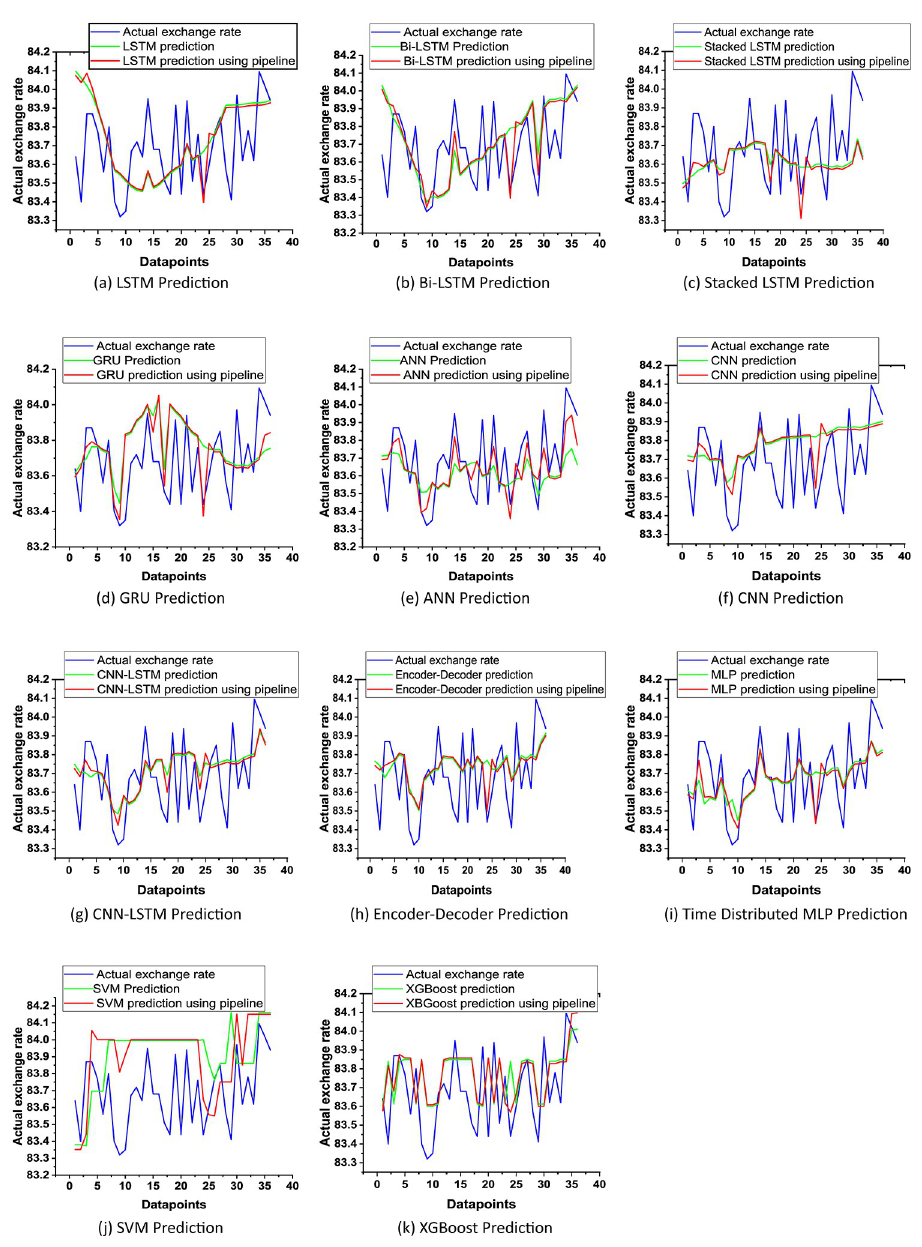
Fig 2. Plotting actual vs. predicted USD/BDT exchange rate by using the base models and also applying proposed pipeline. (a) LSTM, (b) Bi-LSTM, (c) Stacked LSTM, (d) GRU, (e) ANN, (f) CNN, (g) CNN-LSTM, (h) Encoder- Decoder, (i) Time Distributed MLP,(j) SVM, (k) XGBoost.